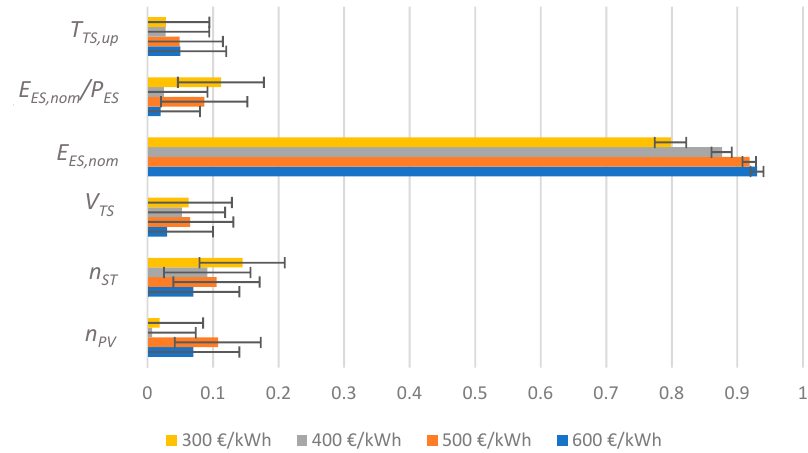
Figure 17. Correlation coe ffi cient between the design variables and the net present value, depending on ES unitary price.